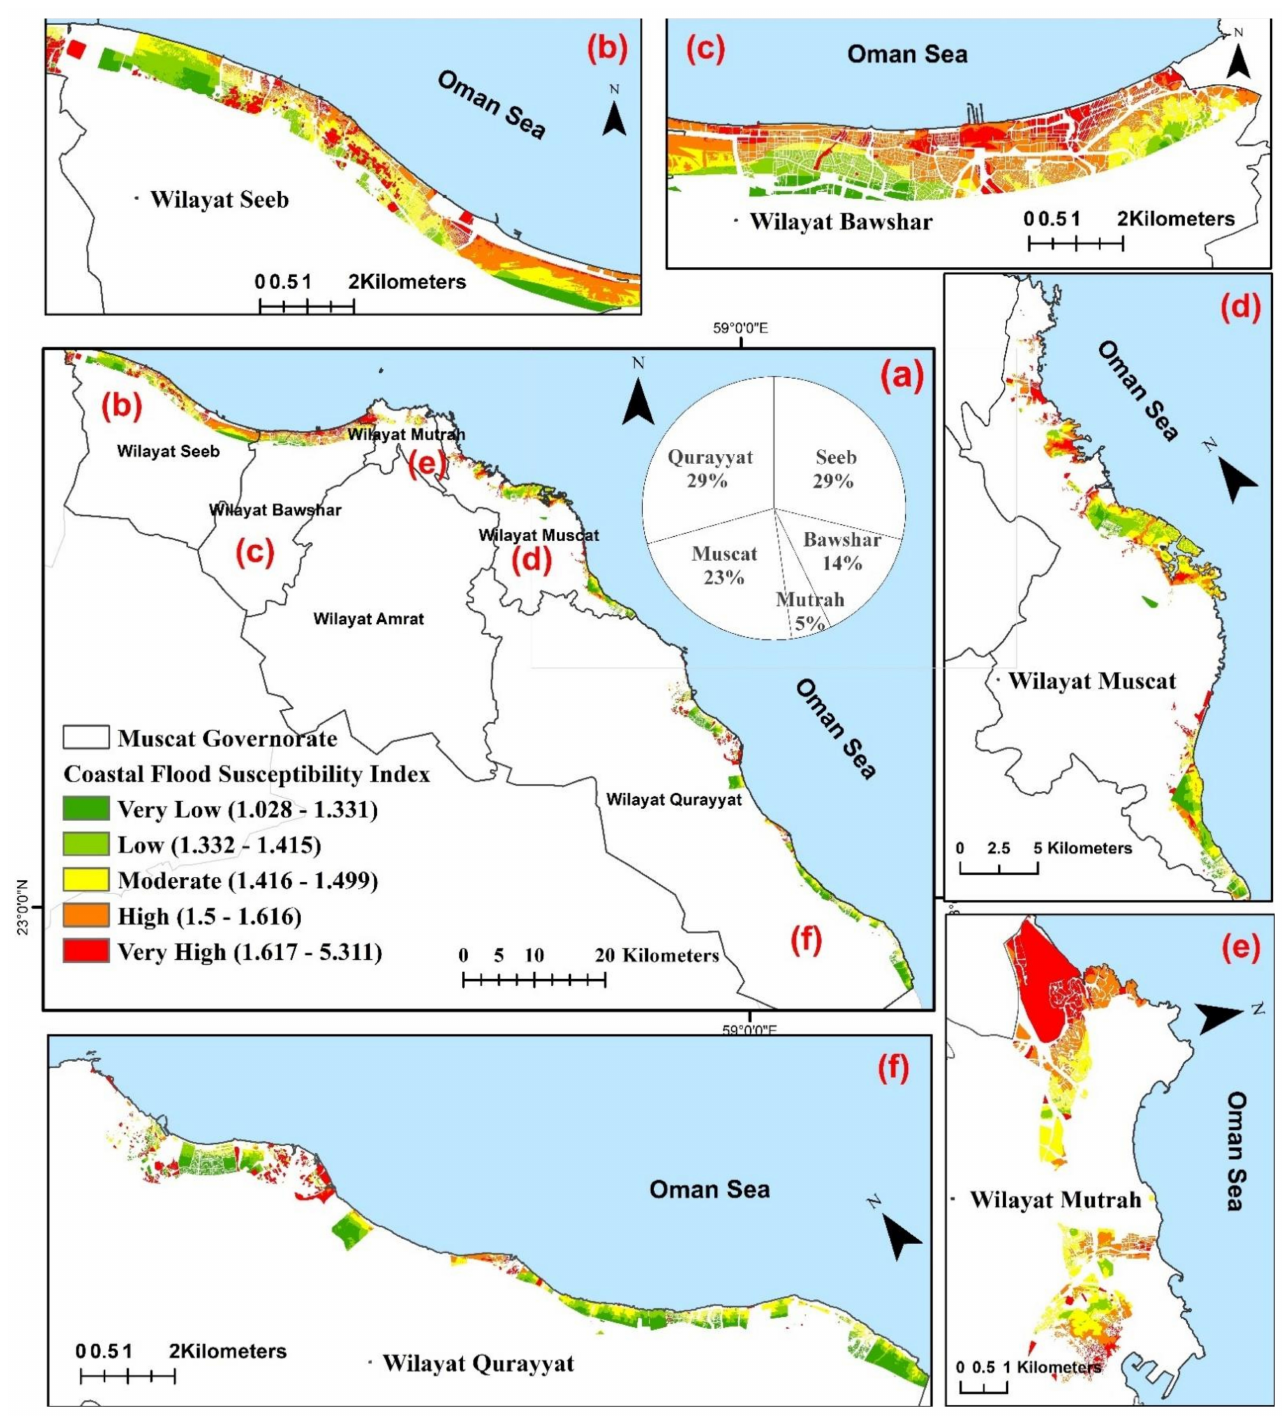
Figure 5. Coastal Flood Susceptibility Index for The ( a ) Governorate of Muscat, ( b ) Wilayat Seeb, ( c ) Wilayat Bawshar, ( d ) Wilayat Muscat, ( e ) Wilayat Mutrah and ( f ) Wilayat